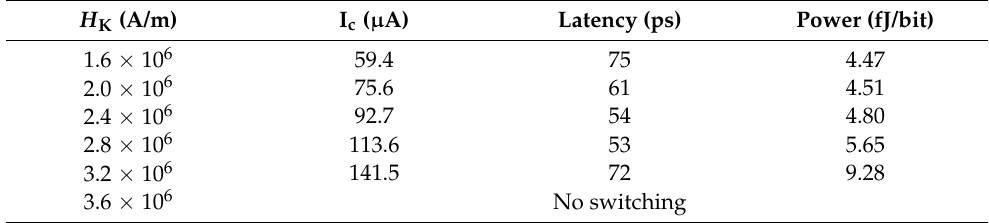
Table 2. Tabulated magnetization switching threshold current, writing latency and power consump- tion of FGT-based MTJ with different magnetic anisotropy ( H k